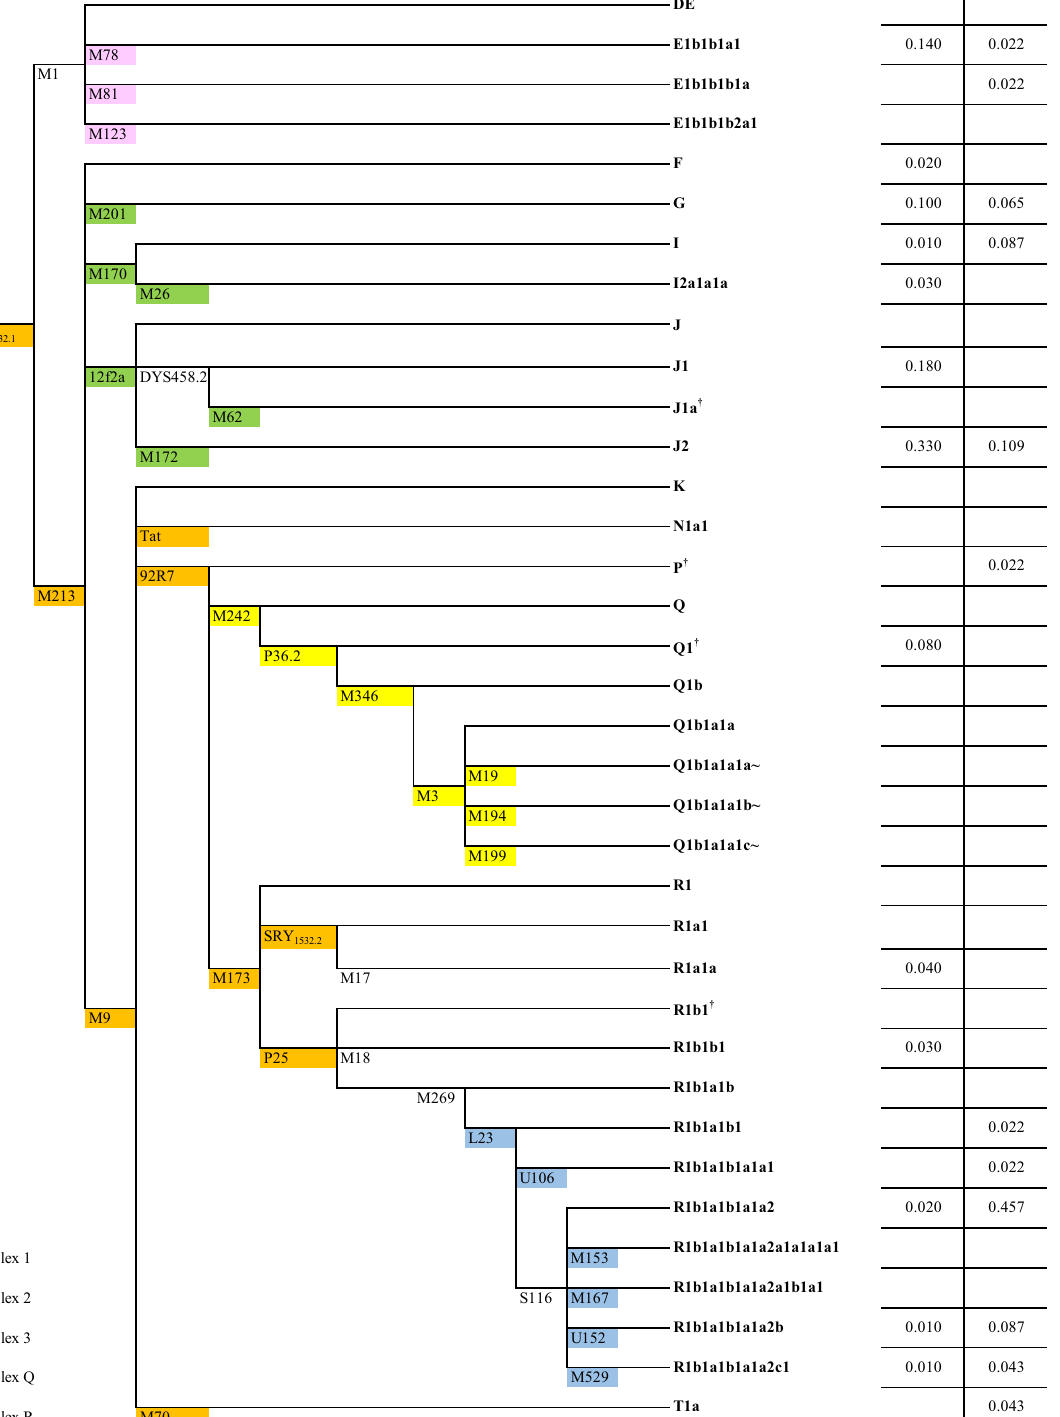
Figure 1. Phylogenetic tree of the 38 Y-SNPs typed, and haplogroup frequencies for Chueta and Majorca populations. Haplogroups were named in accordance with the latest Update of ISOGG 2019. Haplogroups labelled with † are named as in their original description: J1a-M62, P-92R7, and R1b1-P25 (Brion et al. 33 ), and Q1-P36.2 (Roewer et al. 35